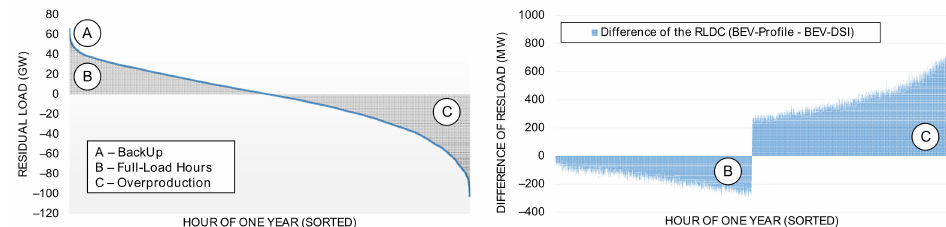
Figure 12. Residual load duration curve, congruent for the BEV scenarios (left graph), with the areas for the back-up need ( A ); full-load-hours ( B ) and overproduction ( C ). The right graph shows the resulting differences between the scenario without and with BEV-DSI concerning the FLH-reduction ( B ) and the overproduction ( C ). Concept of the figure based on